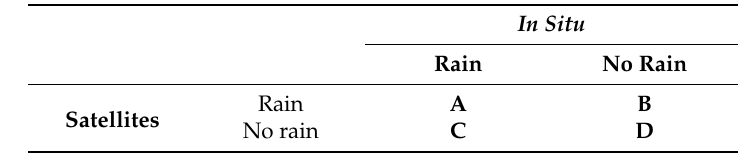
Table 2. Contingency table.“A” represents detected rain events and verified rainfalls. “B” represents the estimated and unobserved rainfalls. “C” represents the undetected rainfalls. “D” corresponds to undetected, but well-classified rainfalls.